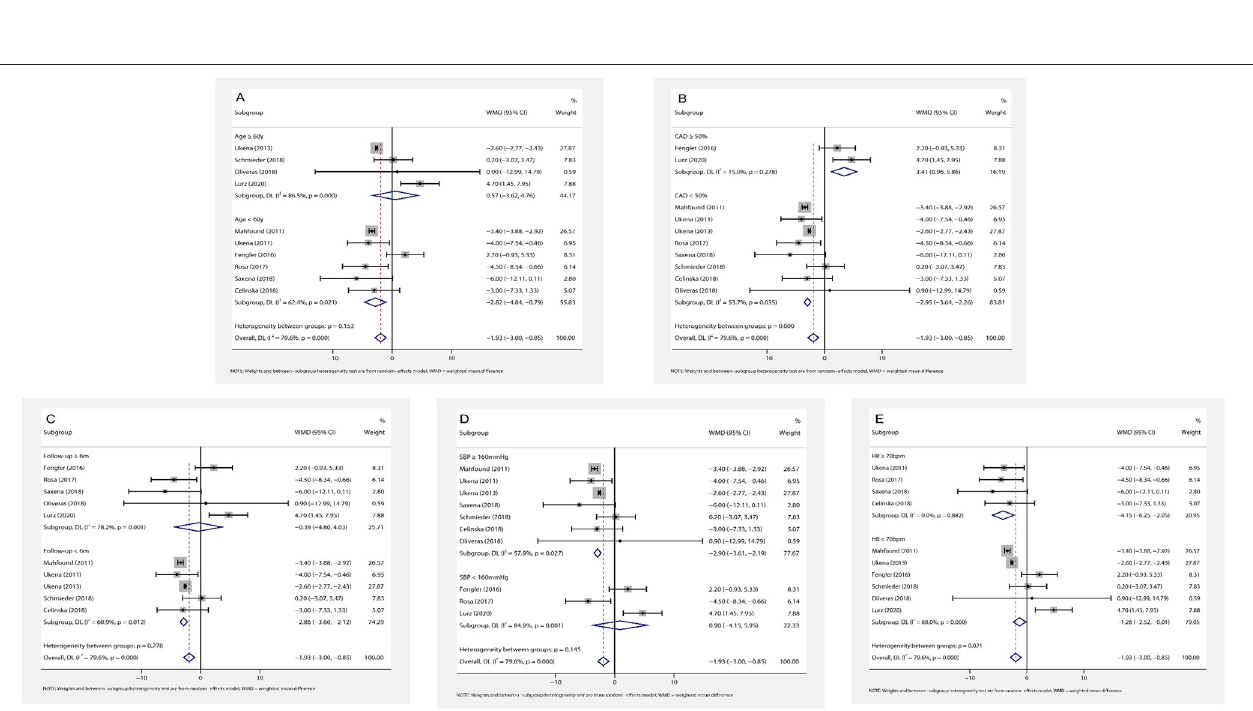
FIGURE 3 | The forest plot of office heart rate (HR) change from baseline. Weights are from random-effects model. WMD, weighted mean difference.